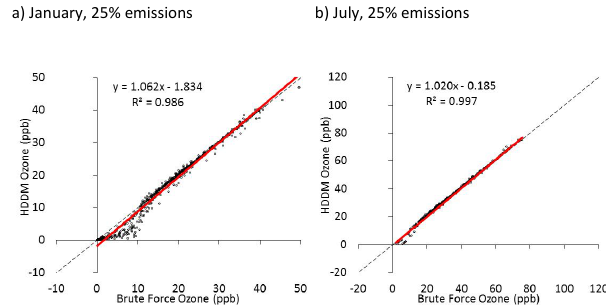
Fig. 9. Hourly ozone at the urban Dallas location predicted by HDDM with Eq. (3) vs. brute force CAMx simulations for (a) 25% anthropogenic NO x (100% VOC) emissions in January, and (b) 25% anthropogenic NO x (100% VOC) emissions in July. Dashed lines show 1 : 1 agreement and solid red lines show least- squares regressions.